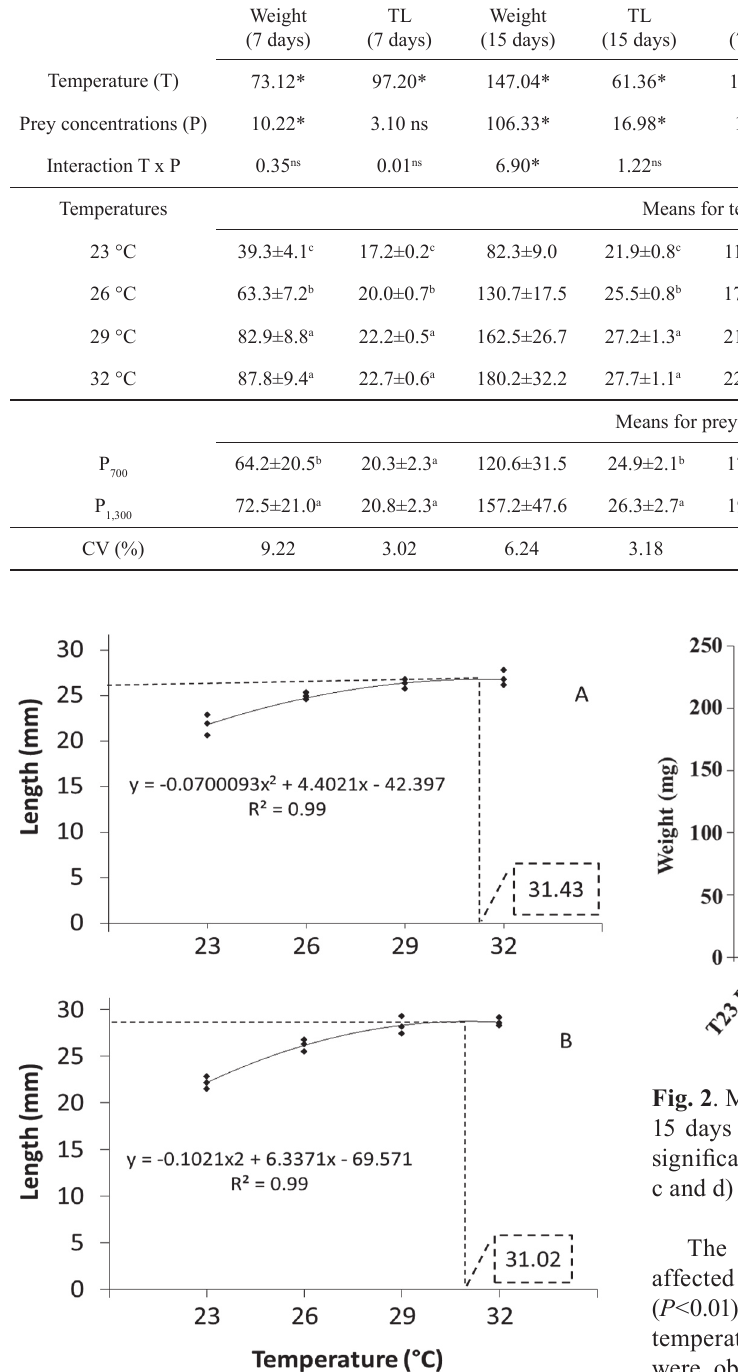
Fig. 1 . Total length of Lophiosilurus alexandri after 15 days of exogenous feeding. The graph “A” and “B” showed the best temperature for the prey concentration P respectively.